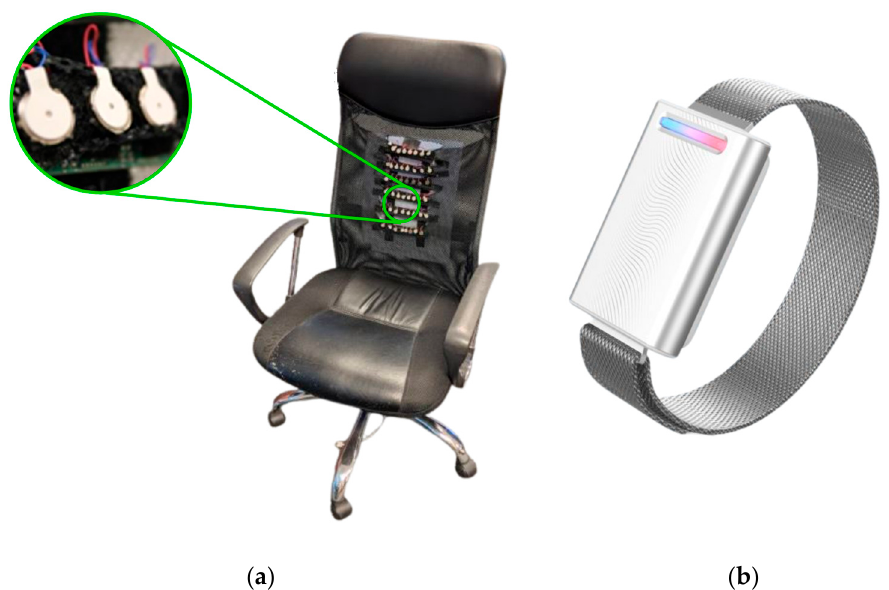
Figure 1. ( a ) Frontal view of the Haptic Chair with close-up of a tactor strip. The vibration motors sit on the mesh itself for closer contact with participant’s skin and to avoid propagation of vibrations that would occur if attached to the rigid printed circuit board directly; ( b ) Embr wave bracelet.